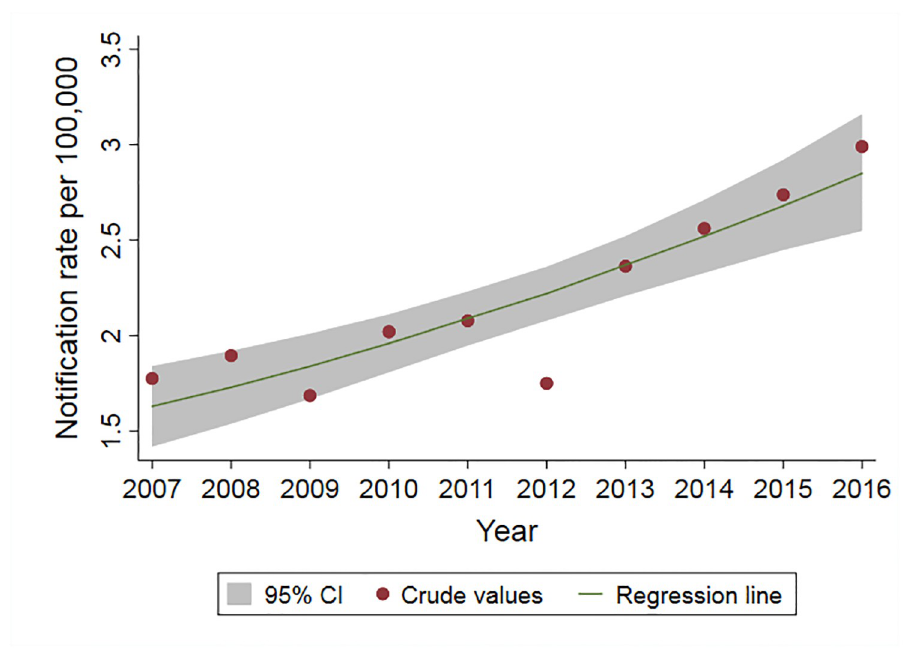
Fig 3. Crude and adjusted notification rates of iNTS disease in Queensland,